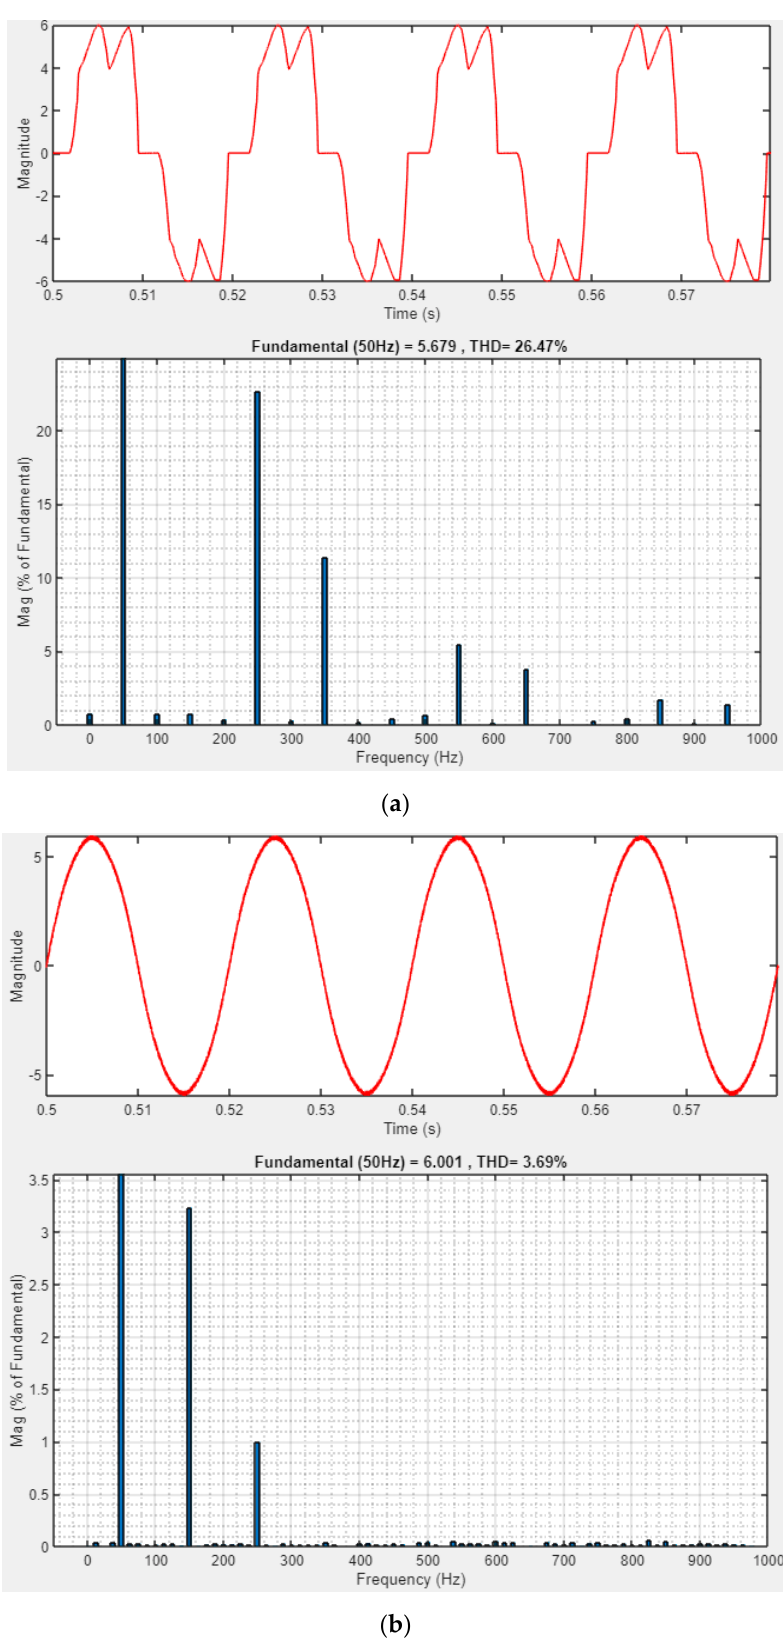
Figure 13. ( a ) Load current THD; ( b ) source current THD.